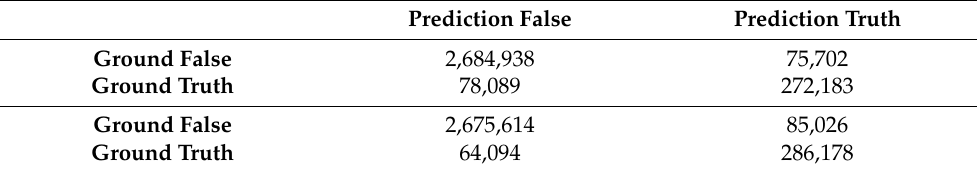
Table 5. Confusion matrix of two models on the Iburi dataset, ResU-Net (up), proposed (down). Prediction False Prediction